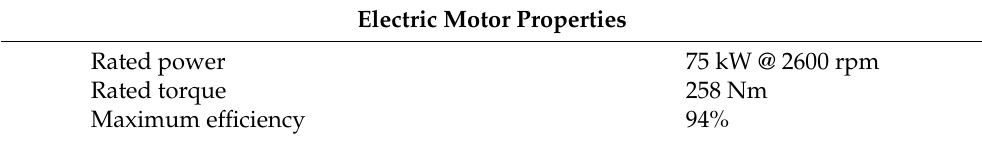
Table 2. Main properties of the Electric Motor.